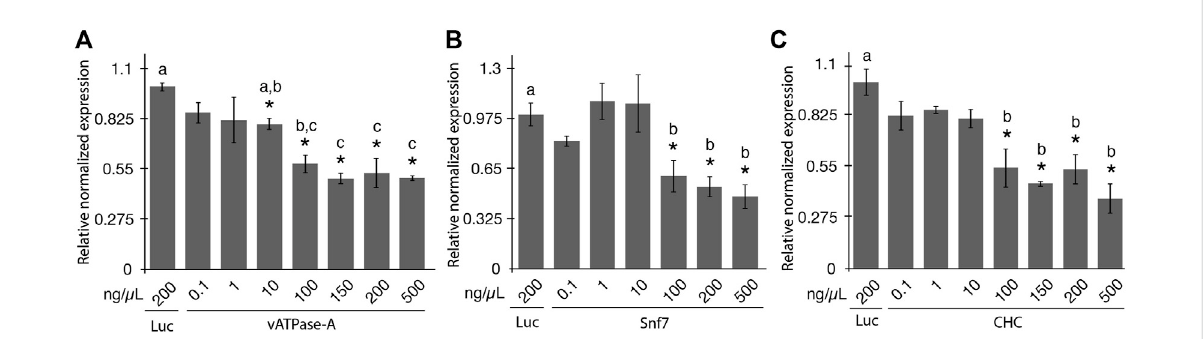
FIGURE 1 Relative normalized expression of potato psyllid (PoP) genes following ingestion of dsRNAs of the different concentrations (A – C) . Relative normalizedexpressionof vATPase-A subunit (A) , Snf7 (B) ,and CHC (C) genesin “ Candidatus Liberibactersolanacearum ” -infectedPoPteneraladults. A 2-day ingestion-access period (IAP) to dsRNAs (100 ng/ μ L, 200 μ L) was provided to psyllids and real time quantitative reverse transcriptase- polymerasechainreactionampli fi cationwascarriedout6 dayspost-IAP.Expressionwasnormalizedtothepsyllidcohortsreceiving200 ng/ μ L of the dsRNA luciferase dsRNA non-target control. The Student ’ s t-test was used to carry out the statistical analysis. Signi fi cant groups ( p -value < 0.0.5) are indicated by an asterisk (*) when the results for the experimental and non-target control groups differed. Lower case letters a-c indicate signi fi cantly different groups, determined by Tukey ’ s HSD test ( p -value 0.05). Each experiment consisted of three to fi ve independent biological replicates, with 10 PoP teneral adults per